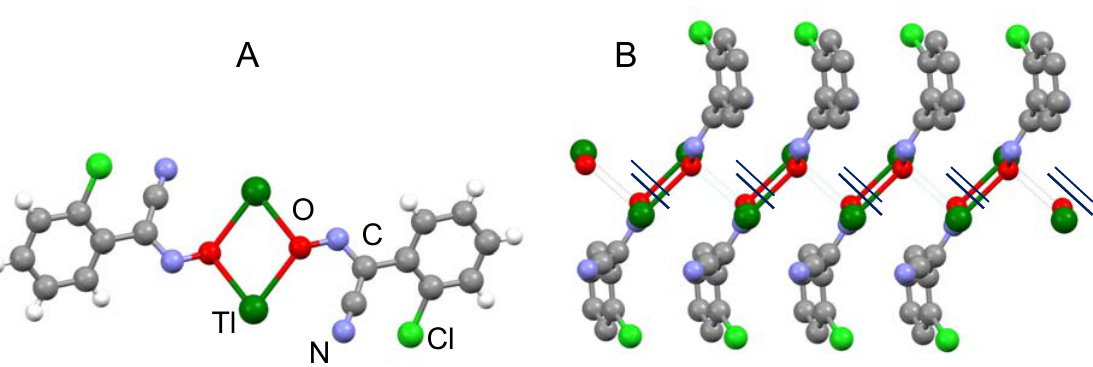
L ( A ), and its fusion into the 2 2